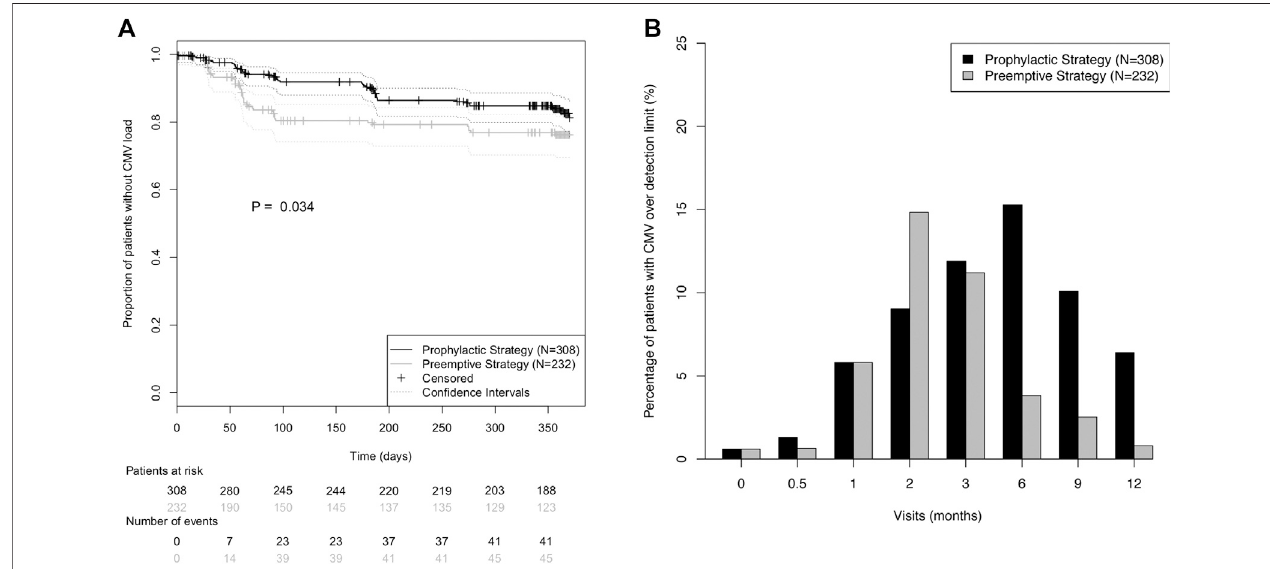
FIGURE2| IncidenceofCMV(re)activationinthepreventionstrategygroupsduringthe fi rstpost-transplant year. (A) Kaplan-MeiercurvesforabsenceofCMV(re) activationduringthe fi rstpost-transplantyear.CMV(re)activationwasde fi nedasviralloadoverdetectionlimit.Preventionstrategygroupswerecomparedusingthe log-rank test. (B) Prevalence of CMV viral load over detection limit for each of the eight protocol visits.